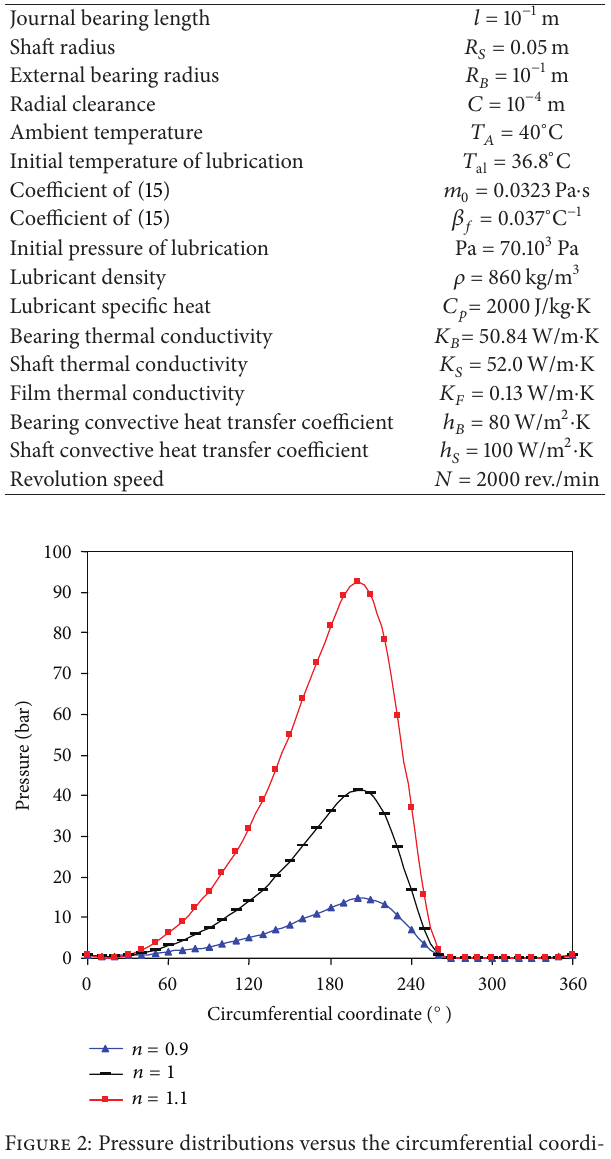
Table 1: Technical data used for the numerical simulation.